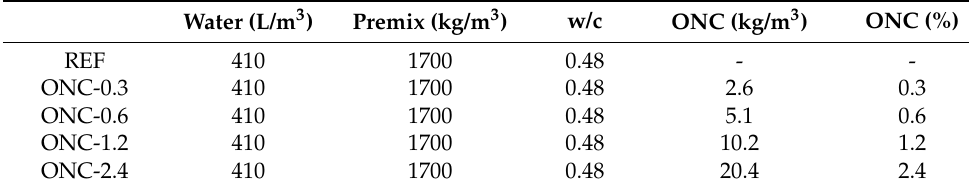
Table 1. Mixture proportion for mortar samples